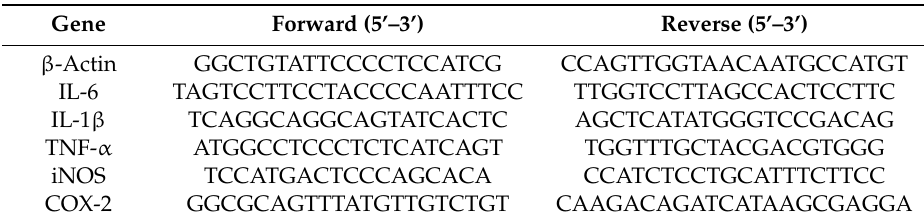
Table 5. The sequences of the primers for